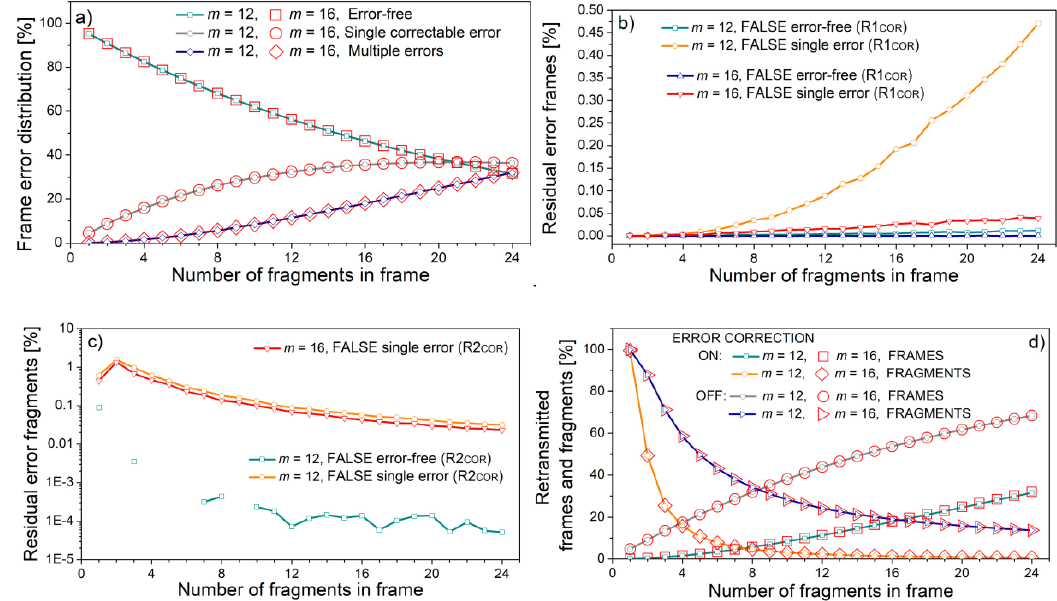
Figure 11. Frame and fragment error events as a function of number of fragments in a frame: ( a ) frame error events distribution; ( b ) residual errors in frame; ( c ) residual errors in fragments; ( d ) retransmitted frames and fragments.